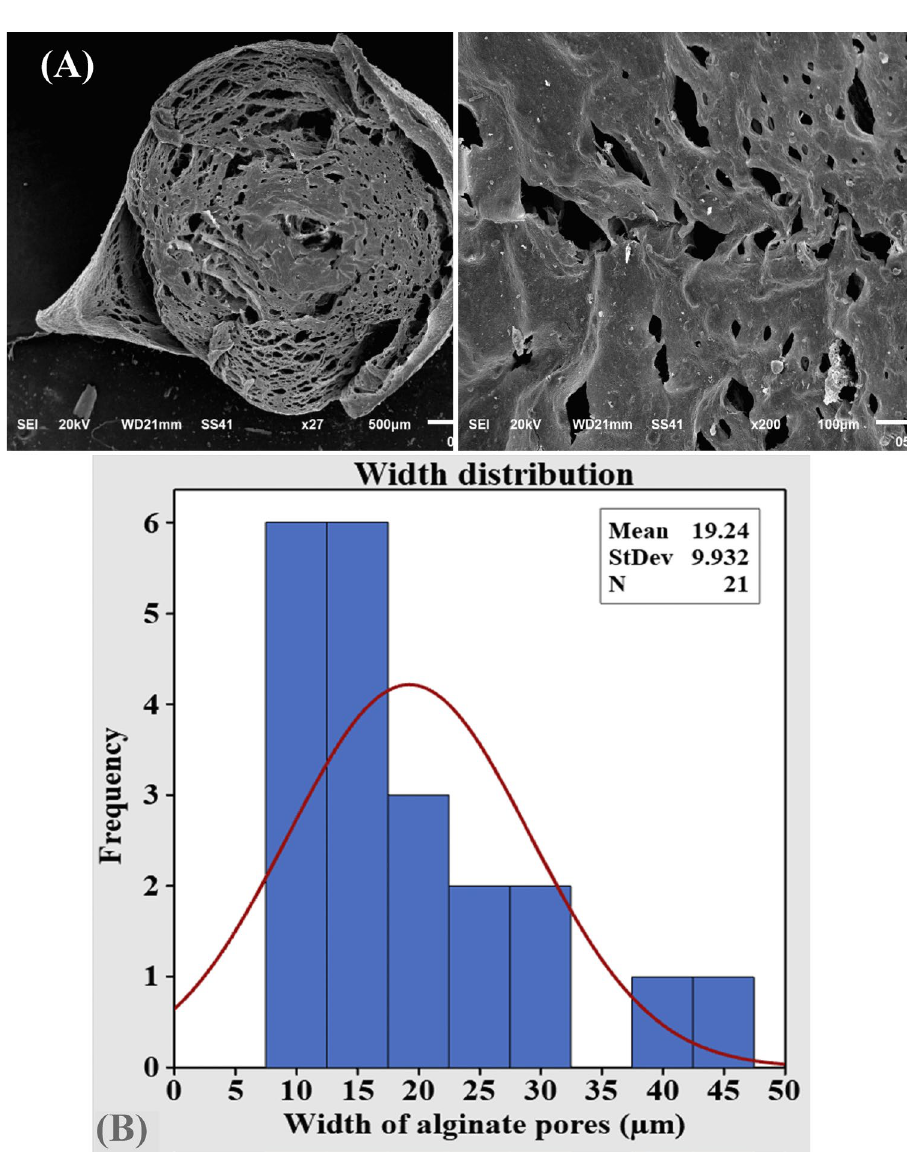
Figure 6. ( A ) SEM electron micrograph of alginate at different magnifications showing alginate pores, ( B ) width ranges of alginate pores versus its